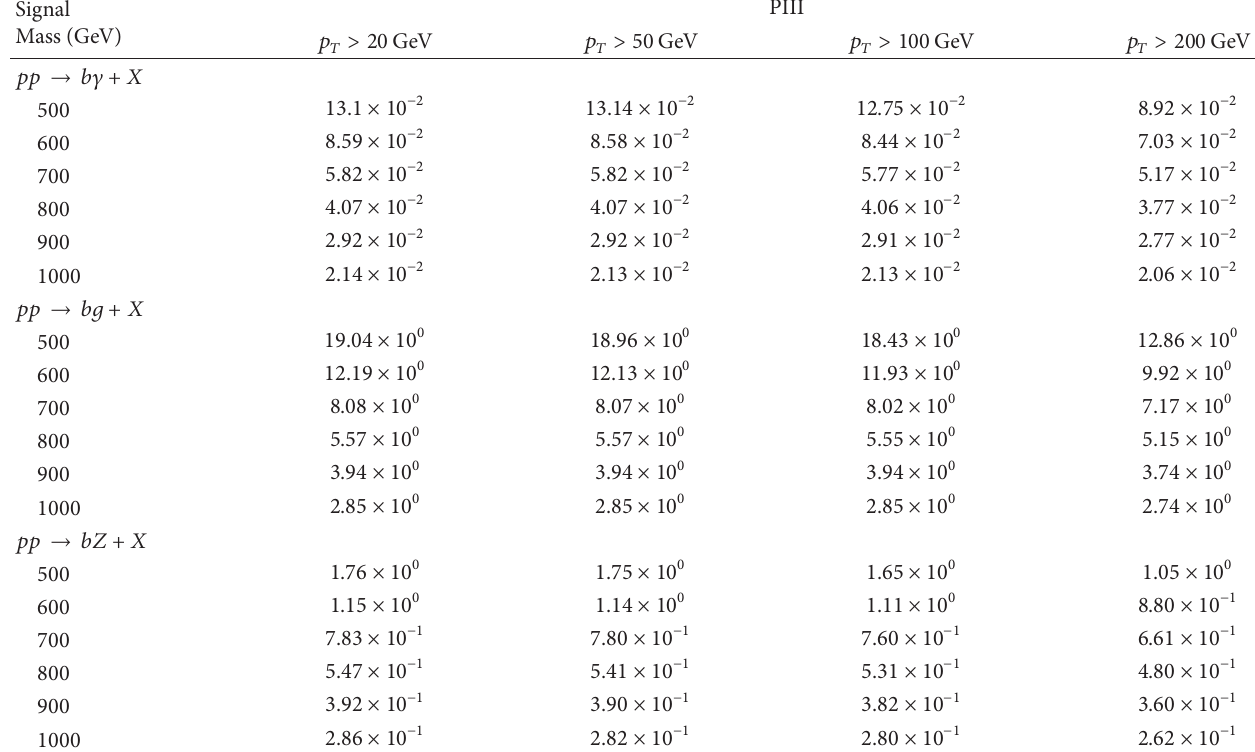
Table 13: The same as Table 11, but for parametrization